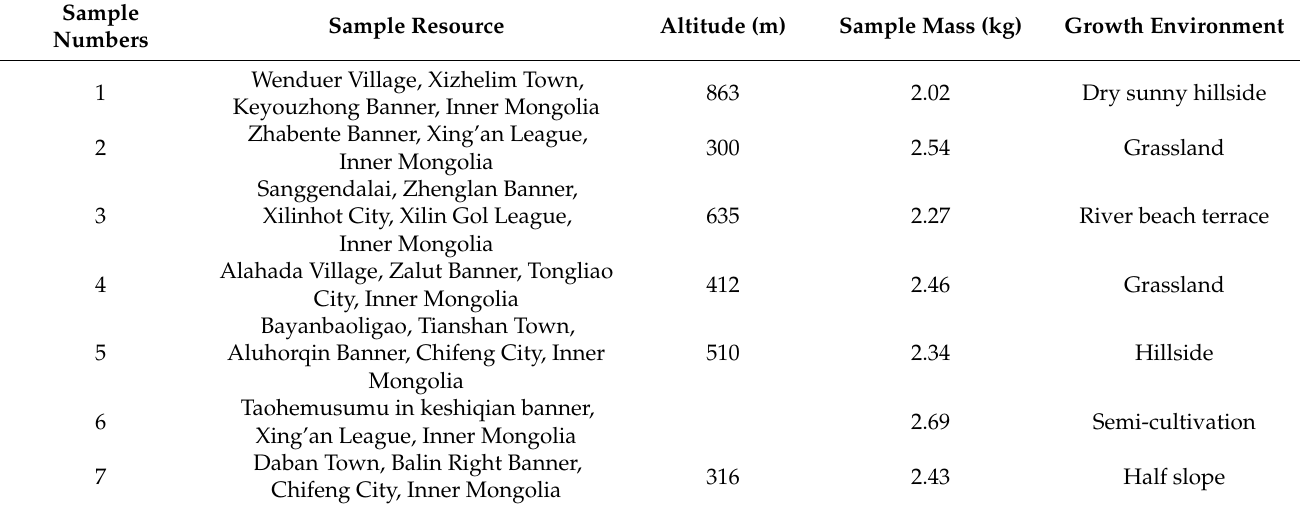
Table 7. Collected information of S. chamaejasme